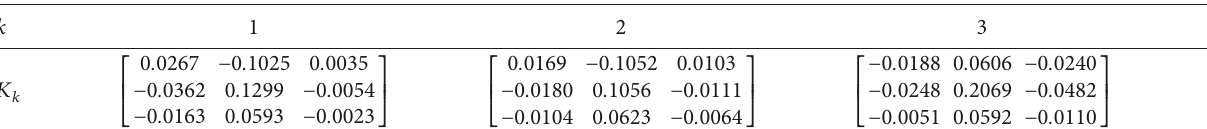
Table 1: The occurrence probabilities of p j